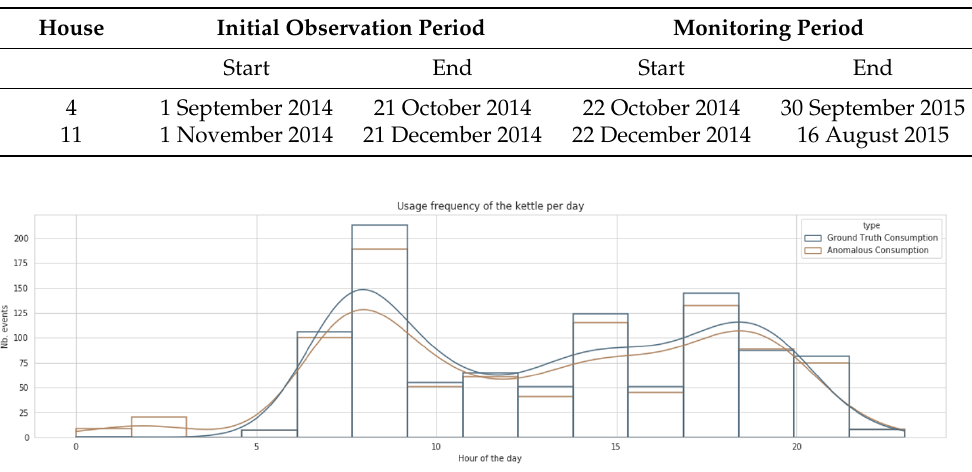
Figure 4. The daily consumption profile of house